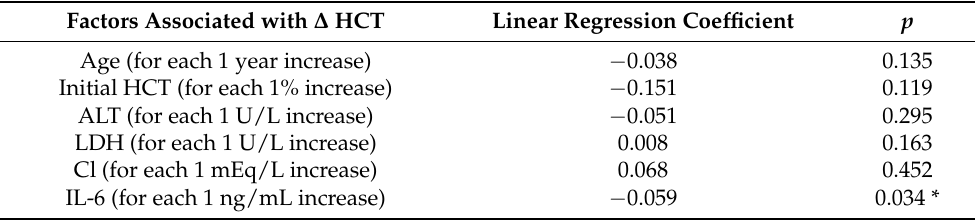
Table 3. Multivariate linear regression model of factors associated with erythropoietic response.